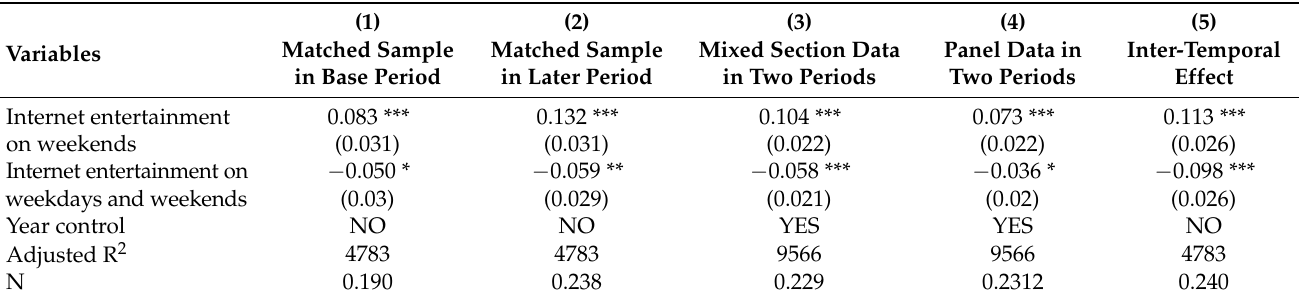
Table 6. Robustness tests of matching data in two